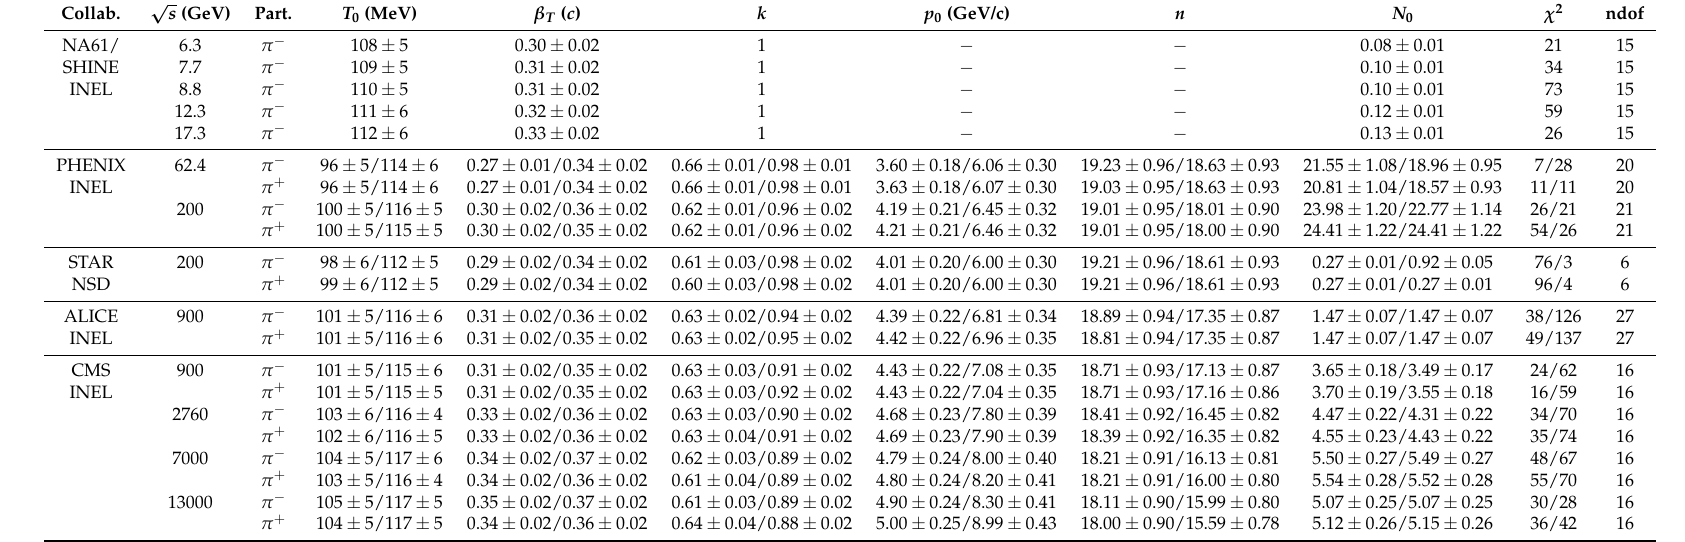
Table 1. Values of free parameters ( T 0 , β T , k , p 0 , and n ), normalization constant ( N 0 ), χ 2 , and ndof corresponding to the solid (dotted) curves for π − ( π + ) spectra in Figure 1 in which different data are measured in different mid-(pseudo)rapidity intervals at different energies by different Collaborations. The values presented in terms of value 1 /value 2 denote respectively the first and second sets of parameter values in Equation (7) through Equations (1) and (3) in which k (cid:54) = 1. √ s (GeV) Collab.